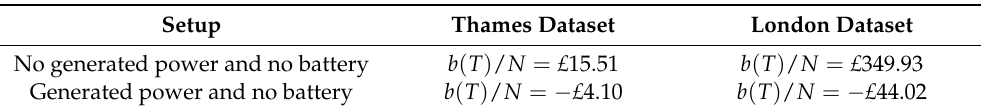
Table 1. Annual energy bills for the average prosumer in the simulated Thames or London environ- ment without battery or generated power.